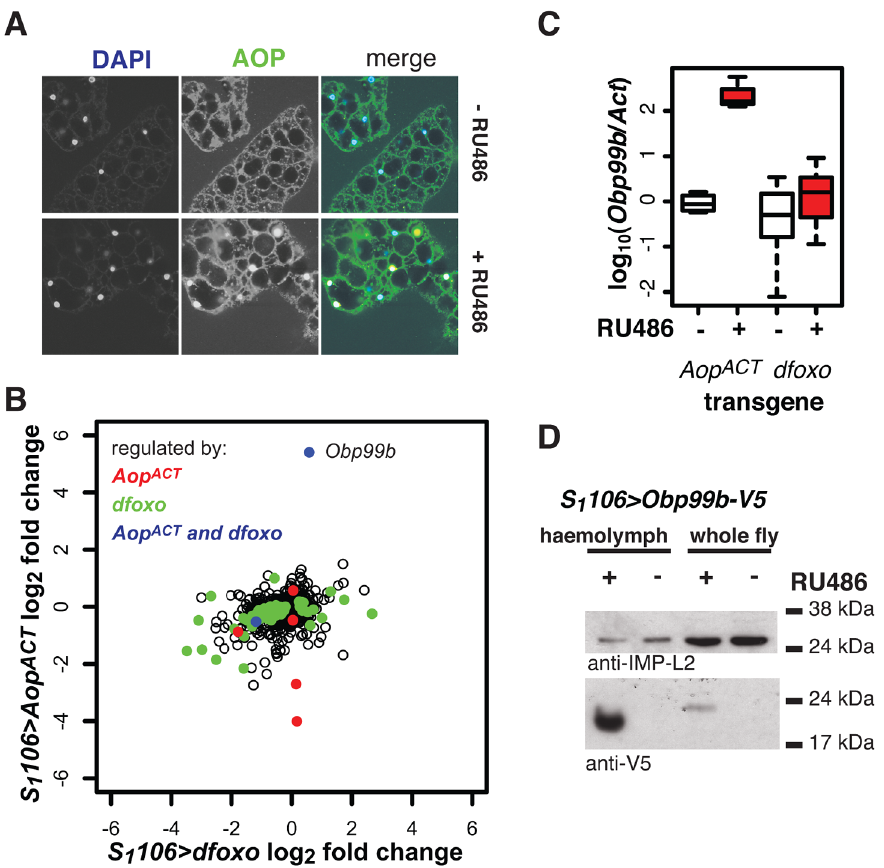
Figure 8. Aop and dfoxo both regulate a humoral factor, Obp99b, in the fat body. A AOP was visualised by immunofuorescence in fat bodies of S 1 106 . Aop ACT flies induced or not with RU486. In the merged image, AOP is shown in green, DAPI-stained nuclei in blue. AOP accumulates in nuclei of 26 6 6% of fat body cells. B Genes regulated by RU486 induction in fat bodies of S 1 106 . Aop ACT flies were determined by microarray analysis and compared to changes in the fat body upon induction of S 1 106 . dfoxo . Mean log 2 fold change caused by induction of Aop ACT (y-axis) is plotted against that caused by induction of dfoxo (x-axis). Genes with significant differential expression (at 20% FDR) upon induction of Aop ACT are shown in red, dfoxo in green and both Aop ACT and dfoxo in blue. The location of the Obp99b gene on the graph is indicated. C The levels of Obp99b mRNA in abdominal fat body mRNAs were determined relative to actin by qPCR upon RU486 induction in S 1 106 . Aop ACT (n=4) or S 1 106 . dfoxo (n=8) female flies. Boxplots show log-10 derived ratios scaled to set the 2 RU486 condition to 0. Data were analysed using a mixed-effects linear model with genotype and RU486 as main effects and dissection batch as a random effect. Both main effects as well as their interaction were significant (p , 0.01), and one-tailed t-test indicated the + RU486 condition had more Obp99b transcript for each genotype (p , 0.05). D Obp99b-V5 was detected in haemolymph (1 m l) of S 1 106 . Obp99b-V5 female flies, fed or not RU486, or in whole-fly extracts (equivalent of half a fly) using anti-V5 antibody. The secreted IMP-L2 protein was used as a loading